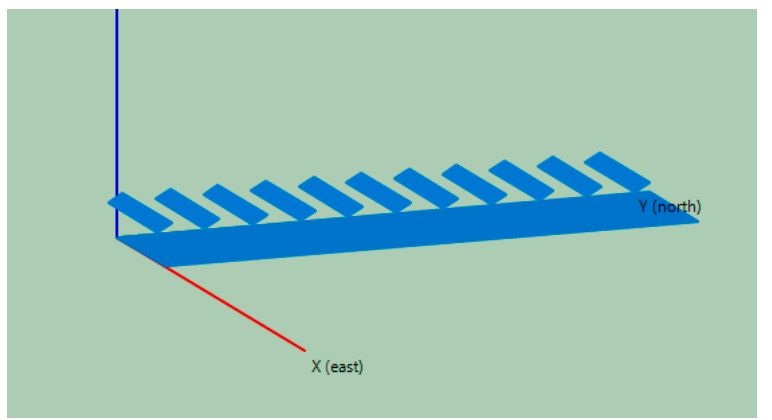
Figure A1. Due south APV shed. Ground area: 26 m × 106 m. Dimensions and number of PV module supporting structures: 26 m × 3.28 m × 11. Equidistance between supporting structures axes: 9.5 m, as in Figure 2.